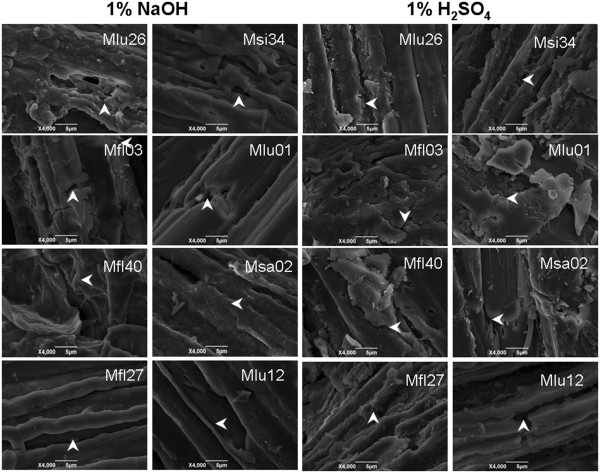
SEM imagines of biomass residues obtained from pretreatment with 1% NaOH or 1% H2SO4, and sequential enzymatic hydrolysis. Sample (Mlu26, Mfl03, Mfl40, Mfl27) with a relatively higher biomass digestibility showing a coarse surface indicated as arrow, and sample (Msi34, Mlu01, Msa02, Mlu12) displaying a flat face.